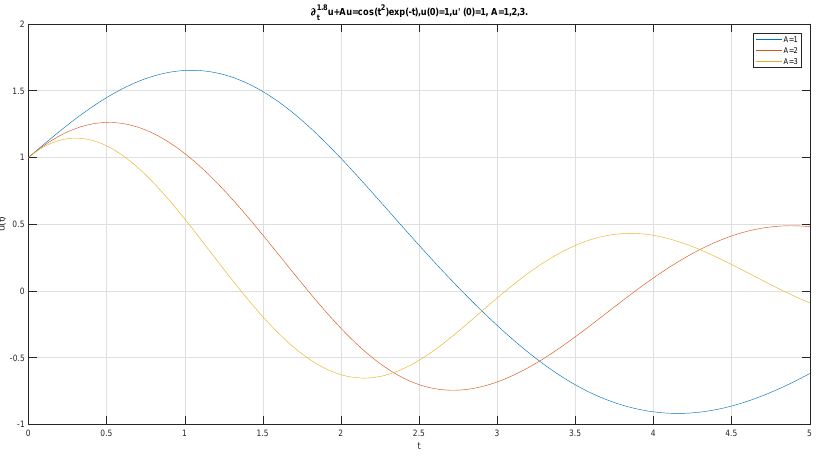
Figure 1. Comparison of solution of ( 33 ) with varied relaxation coefficients, A = 1,2 and